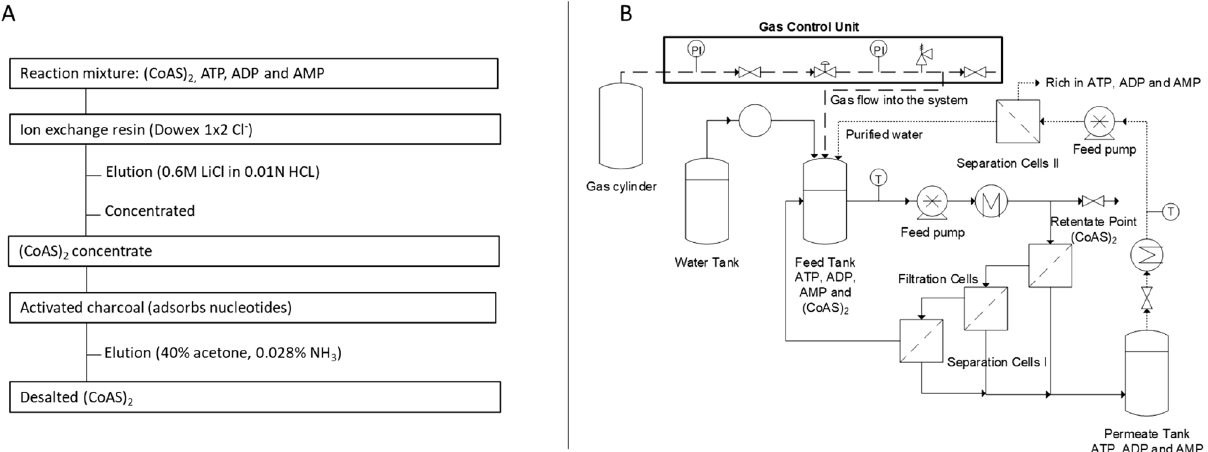
Figure 7. ( A ) Purification of (CoAS) 2 through chromatography-charcoal adsorption/desorption strategy. ( B ) Purification of (CoAS) 2 through cross-flow dia-filtration strategy.